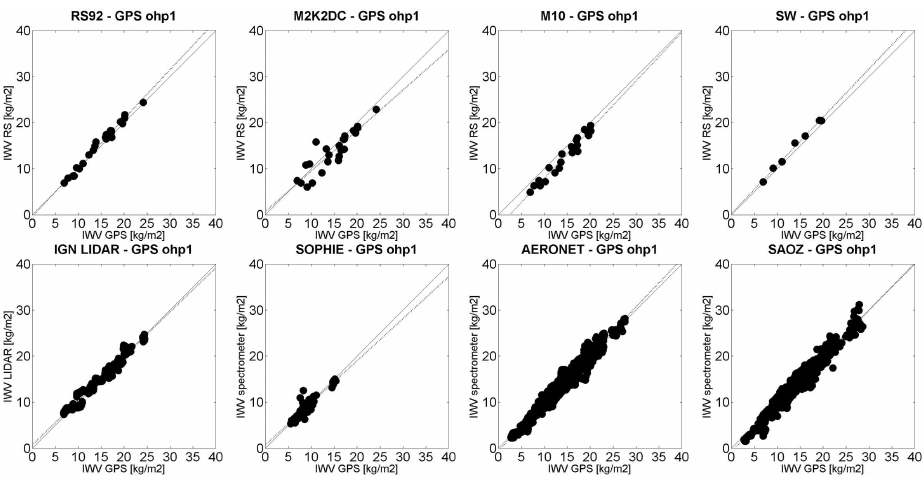
Fig. 16. Scatter plots of IWV from eight instruments to the IWV measured by GPS station OHP1. Table 5. Comparison of IWV measured by eight instruments to IWV measured by GPS station OHP1. BIAS is the mean difference of instrument IWV minus GPS IWV, rel. bias is normalized to GPS IWV, STD is the standard deviation of difference, rel. STD is normalized to GPS IWV, Slope is a parameter from the linear fit of IWV instrument =Slope × IWV GPS +offset, Corr. Coef. Is the linear correlation coefficient; and SF = IWV instrument /IWV GPS is the IWV scale